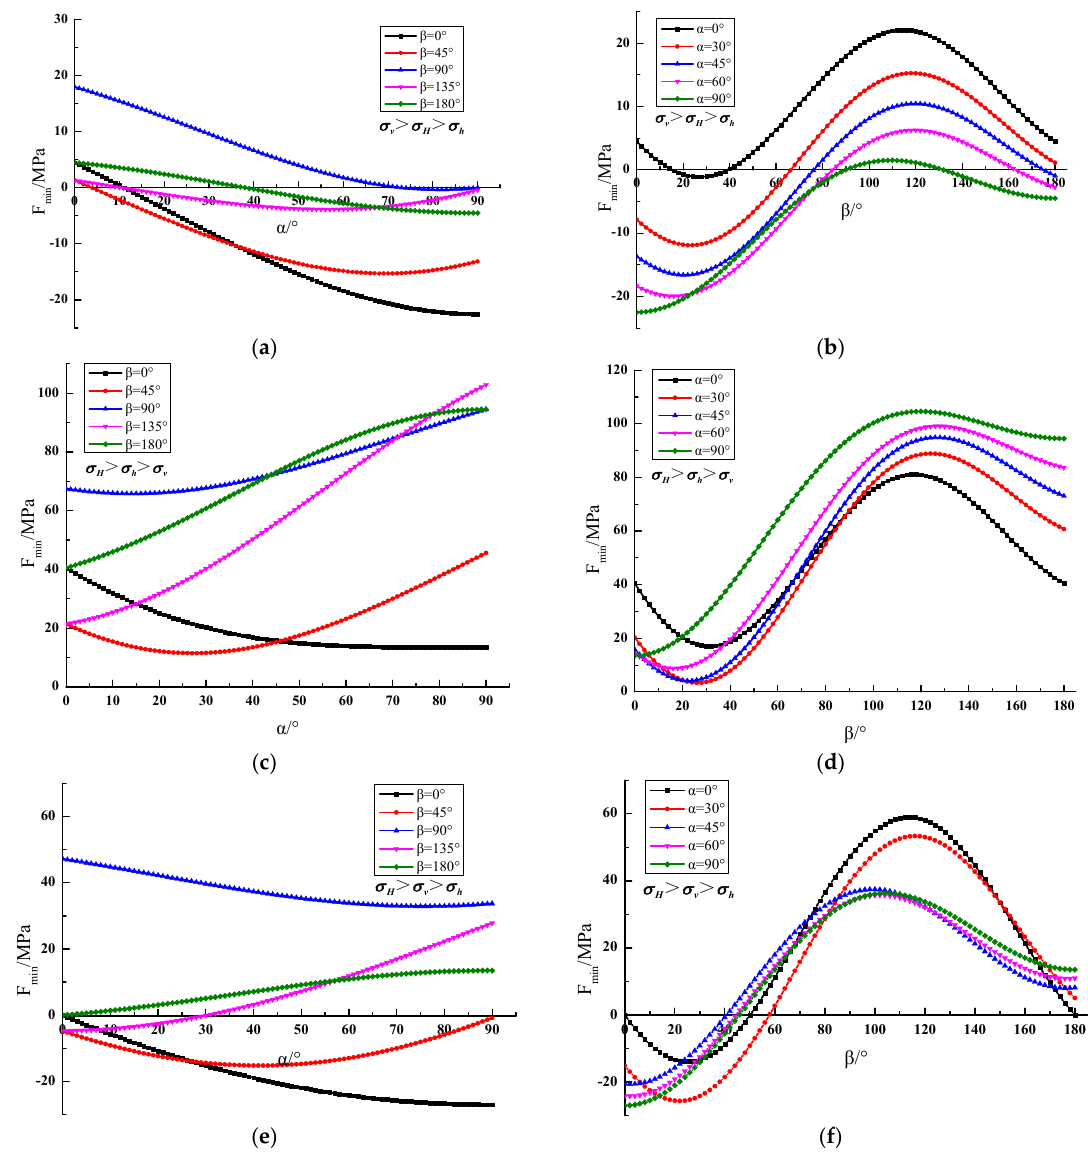
Figure 4. Graph showing F min variation in three different faults. ( a ) Graph showing F min variation with α in a normal fault; ( b ) graph showing F min variation with β in a normal fault; ( c ) graph showing F min variation with α in a reverse fault; ( d ) graph showing F min variation with β in a reverse fault; ( e ) graph showing F min variation with α in a strike ‐ slip fault; and ( f ) graph showing F min variation with β in a strike ‐ slip fault.